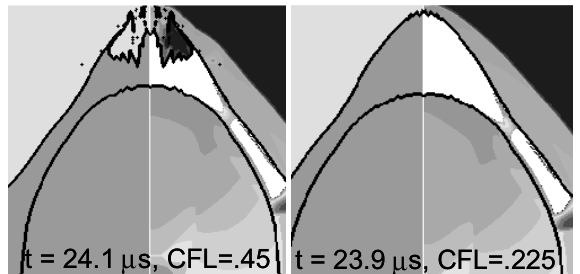
Fig. 14. Plume prior to striking plate.